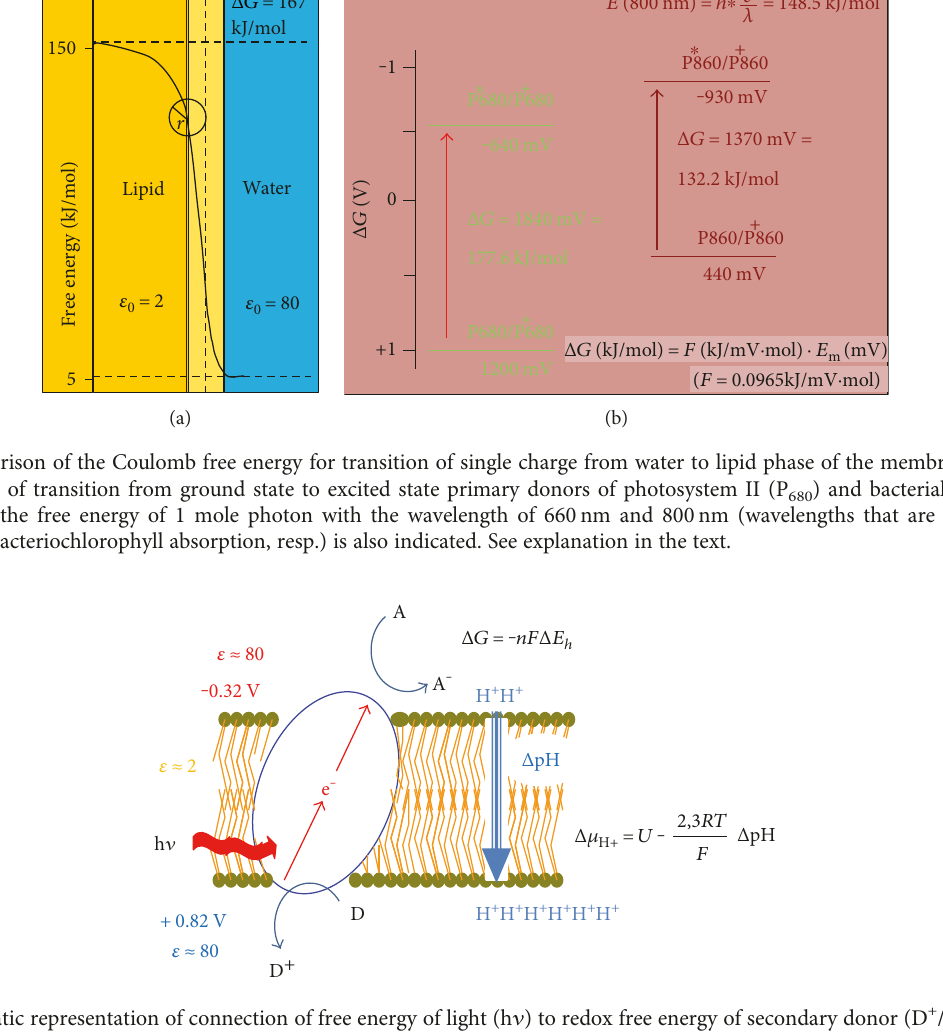
) driven by continuous turnover of the RC protein in the membrane. See H+